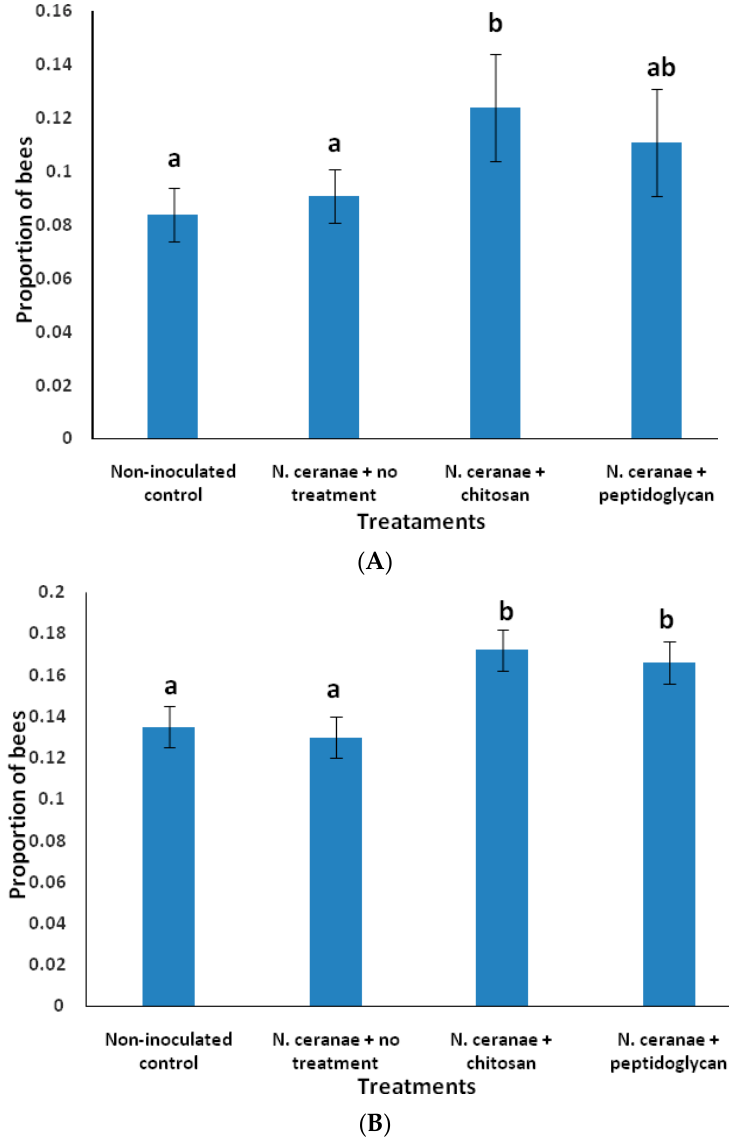
Figure 3. ( A ) Proportion ( ± SE) of worker honey bees that performed pollen foraging trips in 4 h of observation per day. ( B ) Proportion ( ± SE) of worker honey bees that performed non-pollen foraging trips (presumably nectar trips) in 4 h of observation per day. Bees were inoculated with 1 × 10 5 spores of N. ceranae only ( N. ceranae + no treatment), inoculated with N. ceranae and 1.0 µ g / µ L of chitosan ( N. ceranae + chitosan), N. ceranae and 1.0 µ g / µ L of peptidoglycan ( N. ceranae + peptidoglycan) or not inoculated or treated (Non-inoculated control) (n = 500 per treatment). Di ff erent literals above bars indicate significant di ff erences based on ANOVA and Fisher protected LSD tests performed on arcsine square-root transformed data. Actual non-transformed values are depicted.